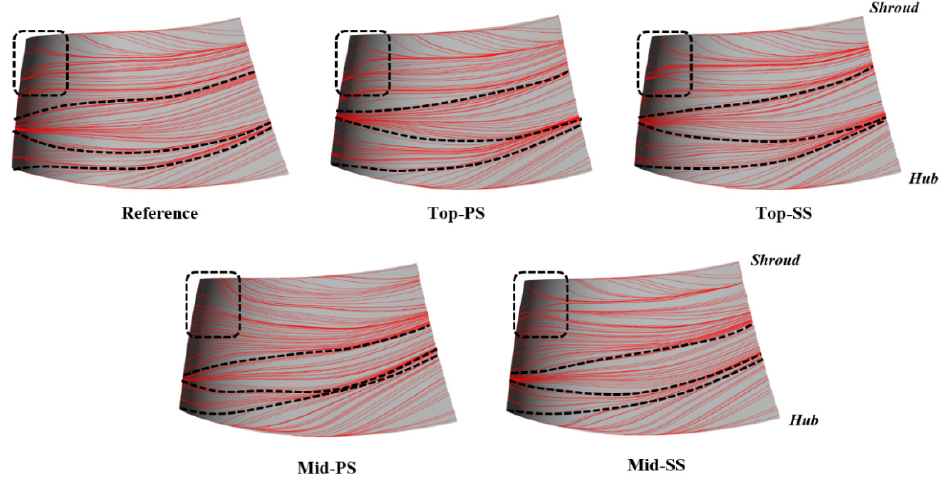
Figure 12. Velocity streamlines at the suction side of the S 2 vane surface.